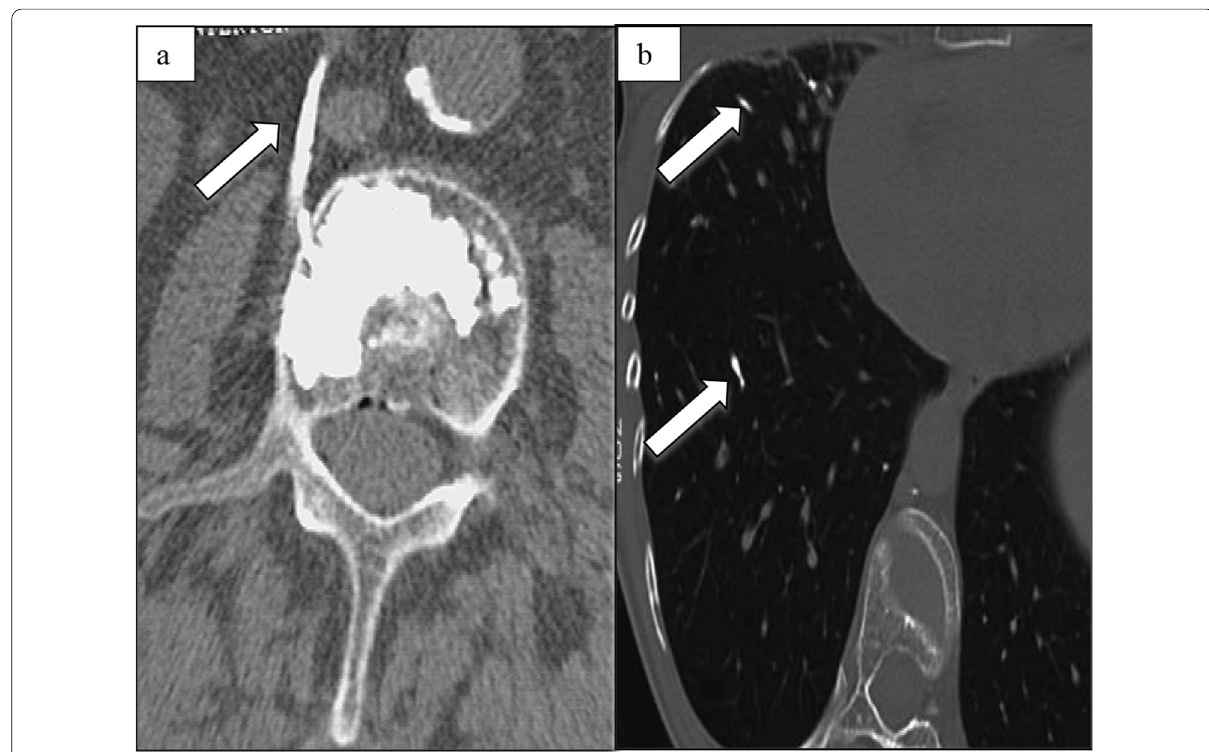
Fig. 4 a L4 post‑kyphoplasty CT scan in axial section: cement leakage with compression of the right iliac vein (arrow); b Thoracic CT scan with contrast injection in axial section: right post‑kyphoplasty pulmonary embolism